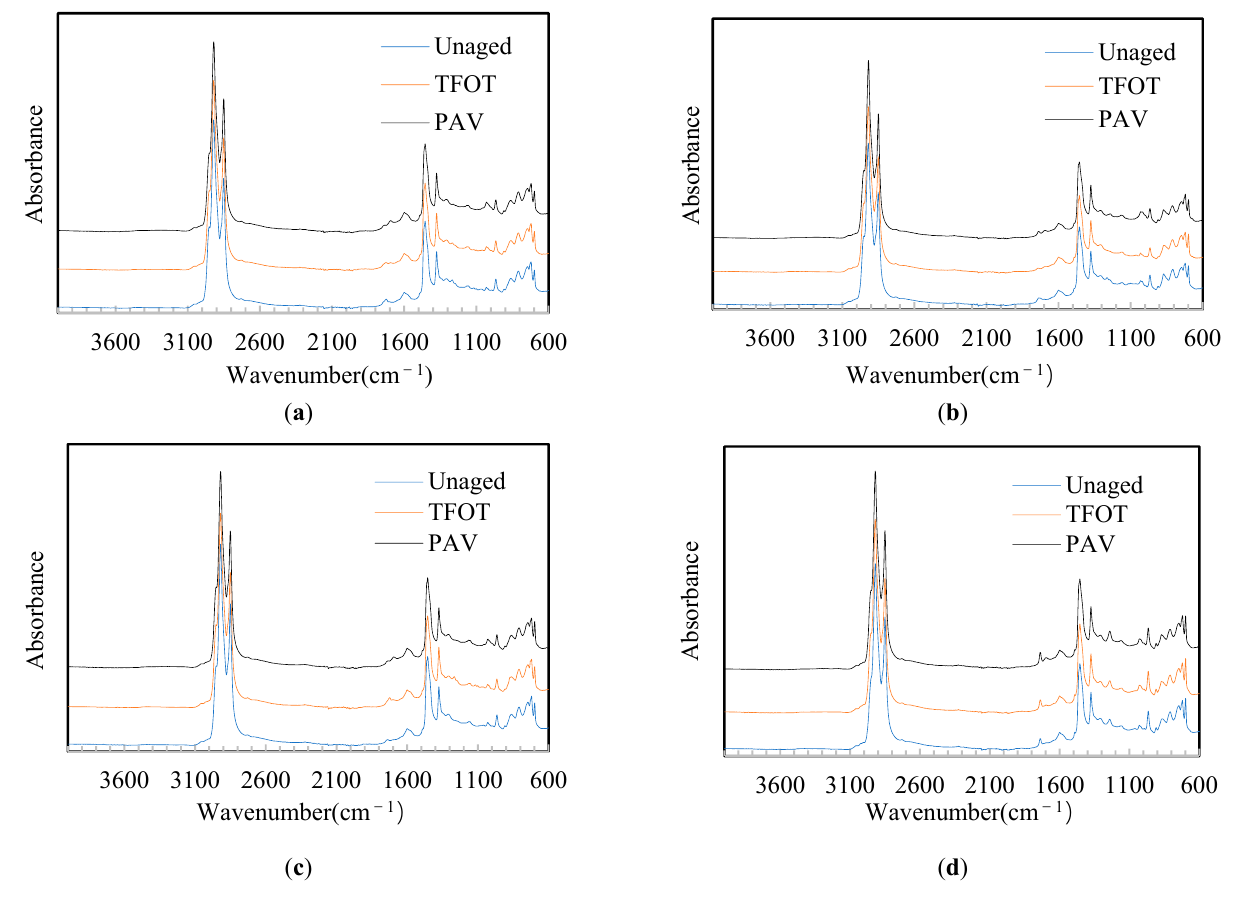
Figure 3. FTIR of asphalt binders after aging: ( a ) SBS; ( b ) HMM-SBS; ( c ) ARA-SBS; ( d ) HVM-SBS.